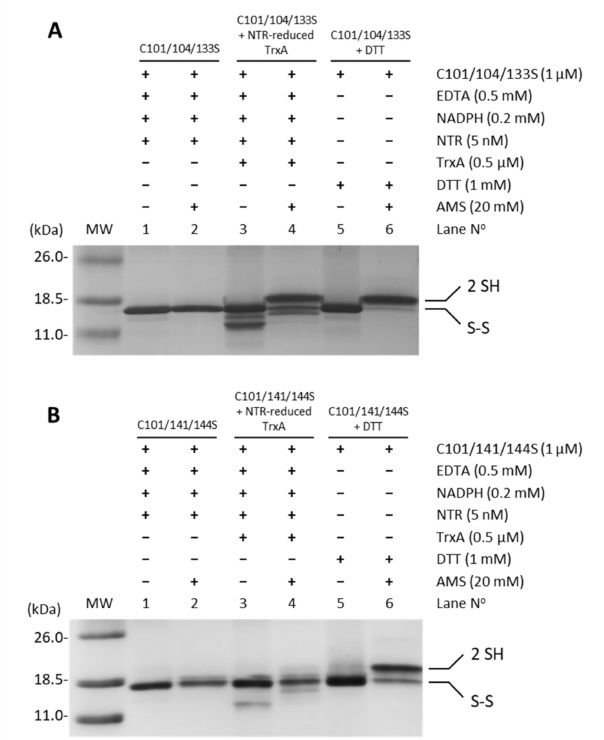
Figure 4. Reduction of disulfide bridges C141-C144 and C104-C133 of FurA by TrxA. One micromolar of FurA triple cysteine mutants C101/104/133S ( A ) and C101/104/133S ( B ) were incubated with 0.5 µ M TrxA in the presence of 0.2 mM NADPH, 0.5 mM EDTA, and 5 nM NTR to assess their reduction by NTR-reduced TrxA. FurA triple cysteine mutants were also incubated with 0.2 mM NADPH and 5 nM NRT to determine whether NADPH-reduced NTR affected their redox status and with 1 mM DTT as a positive control for protein reduction. Proteins were then precipitated with 10% ( w / v ) TCA, incubated with 20 mM AMS, loaded on non-reducing 15% SDS–polyacrylamide gels and stained with Coomassie.